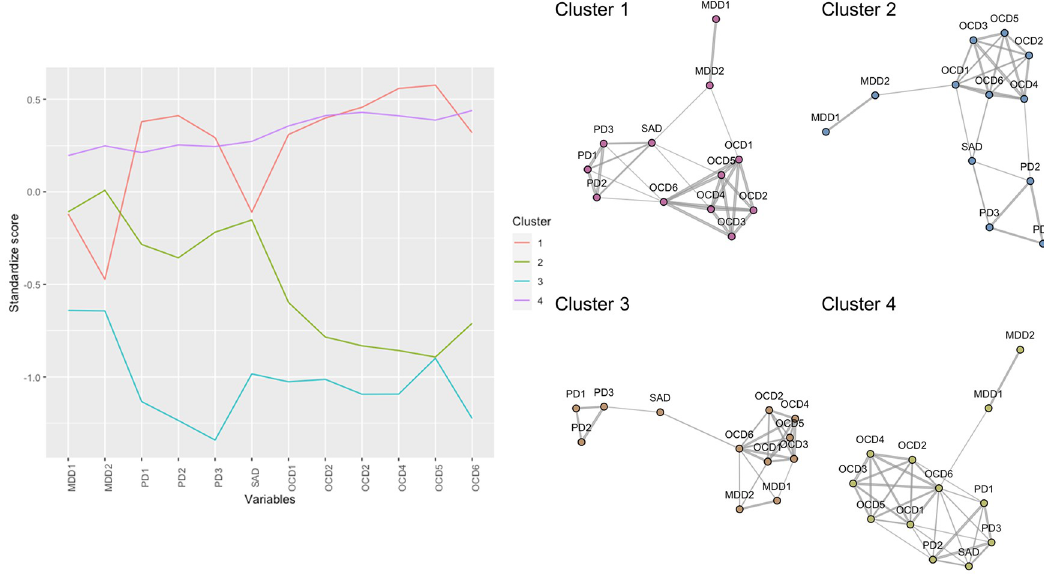
Fig 2. The symptom-profile of patient clusters identified by GGMM (left panel) and the covariance symptom network estimated for each cluster (right panel). The thickness of edges in the symptom networks reflects the values of covariances. MDD = major depressive disorder, PD = panic disorder, SAD = social anxiety disorder, OCD = obsessive-compulsive disorder. MDD1 = cognitive/affective symptoms, MDD2 = somatic symptoms, PD1 = physical concerns, PD2 = cognitive concerns, PD3 = social concerns, OCD1 = hoarding, OCD2 = checking, OCD3 = ordering, OCD4 = neutralizing, OCD5 = washing, OCD6 = obsessing.